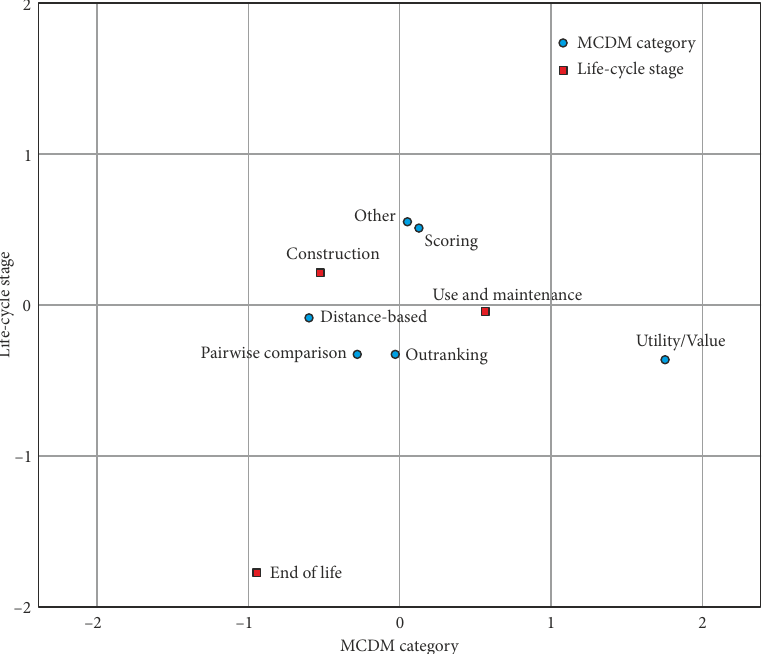
usedFigure 11. Simple correspondence analysis for life cycle stage assessed and MCDM category